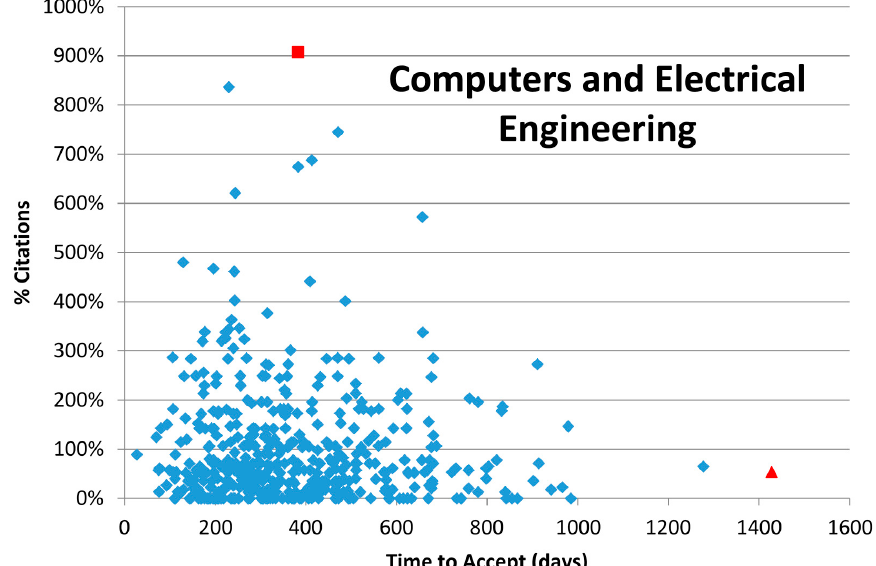
Figure 4. Scatter plot of times to accept versus citations (as percentage ratio of citations to citations per paper in a specific year) of papers from Computers and Electrical Engineering ( n = 469, r = − 0.04). Extreme outliers are marked with red symbols: A rectangle Reference [16] and a triangle Reference [17].